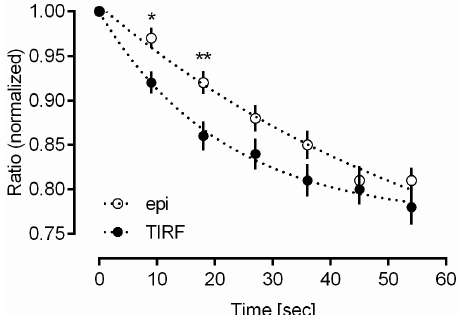
Figure 5. Ratio (I 2 − I 1 )/(I 2 + I 1 ) in HEK 293 cells as a measure of energy transfer. Means ± SEM ( n = 10) upon epi-illumination and TIR illumination over a period of one minute in intervals of 9 s after application of NECA (levels of significance: * p < 0.05 and ** p < 0.01 for comparison of epi- and TIR-illumination). All starting values were normalized to 1. Data points were fitted using a single-exponential decay function (Graphpad Prism).